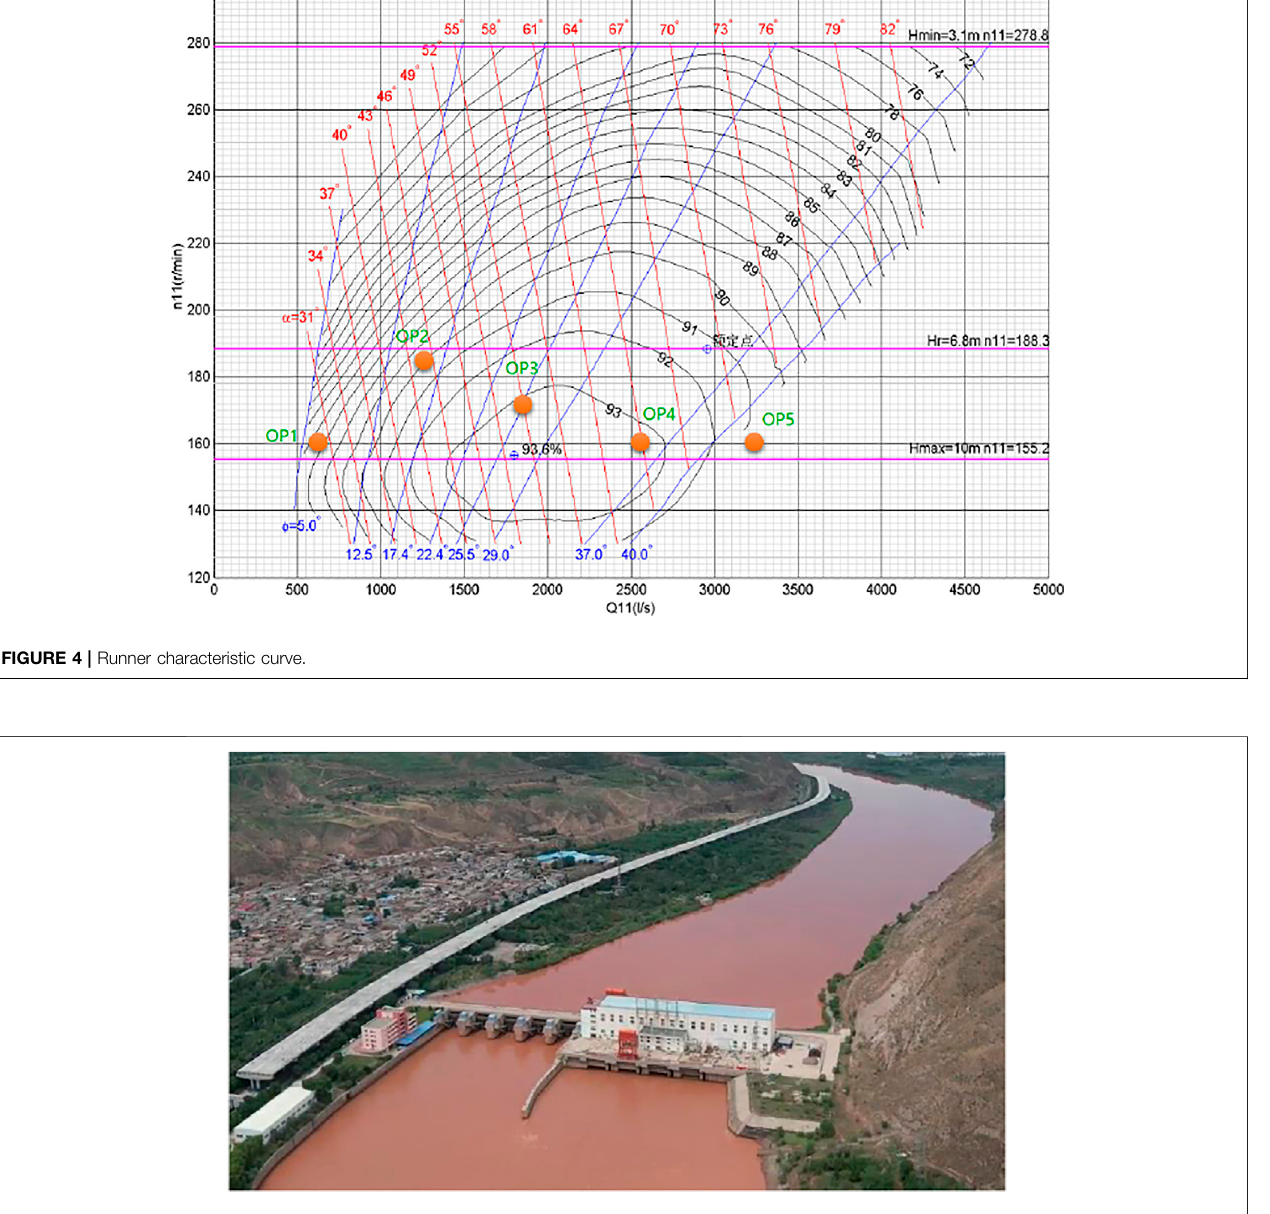
FIGURE 5 | Chaijiaxia hydropower